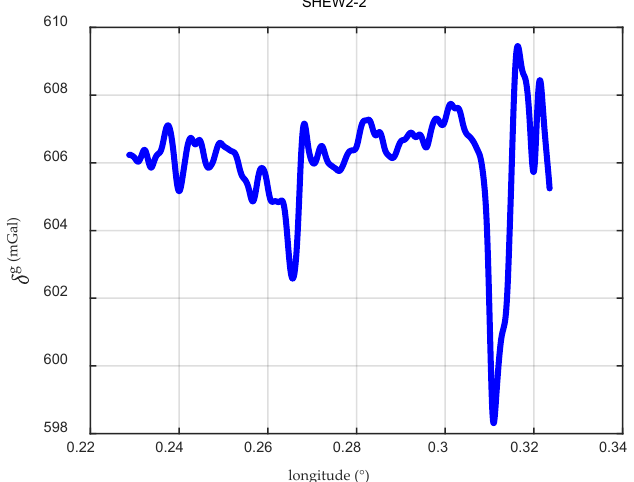
Figure 3. Gravity-measurement results of SHEW2-2.